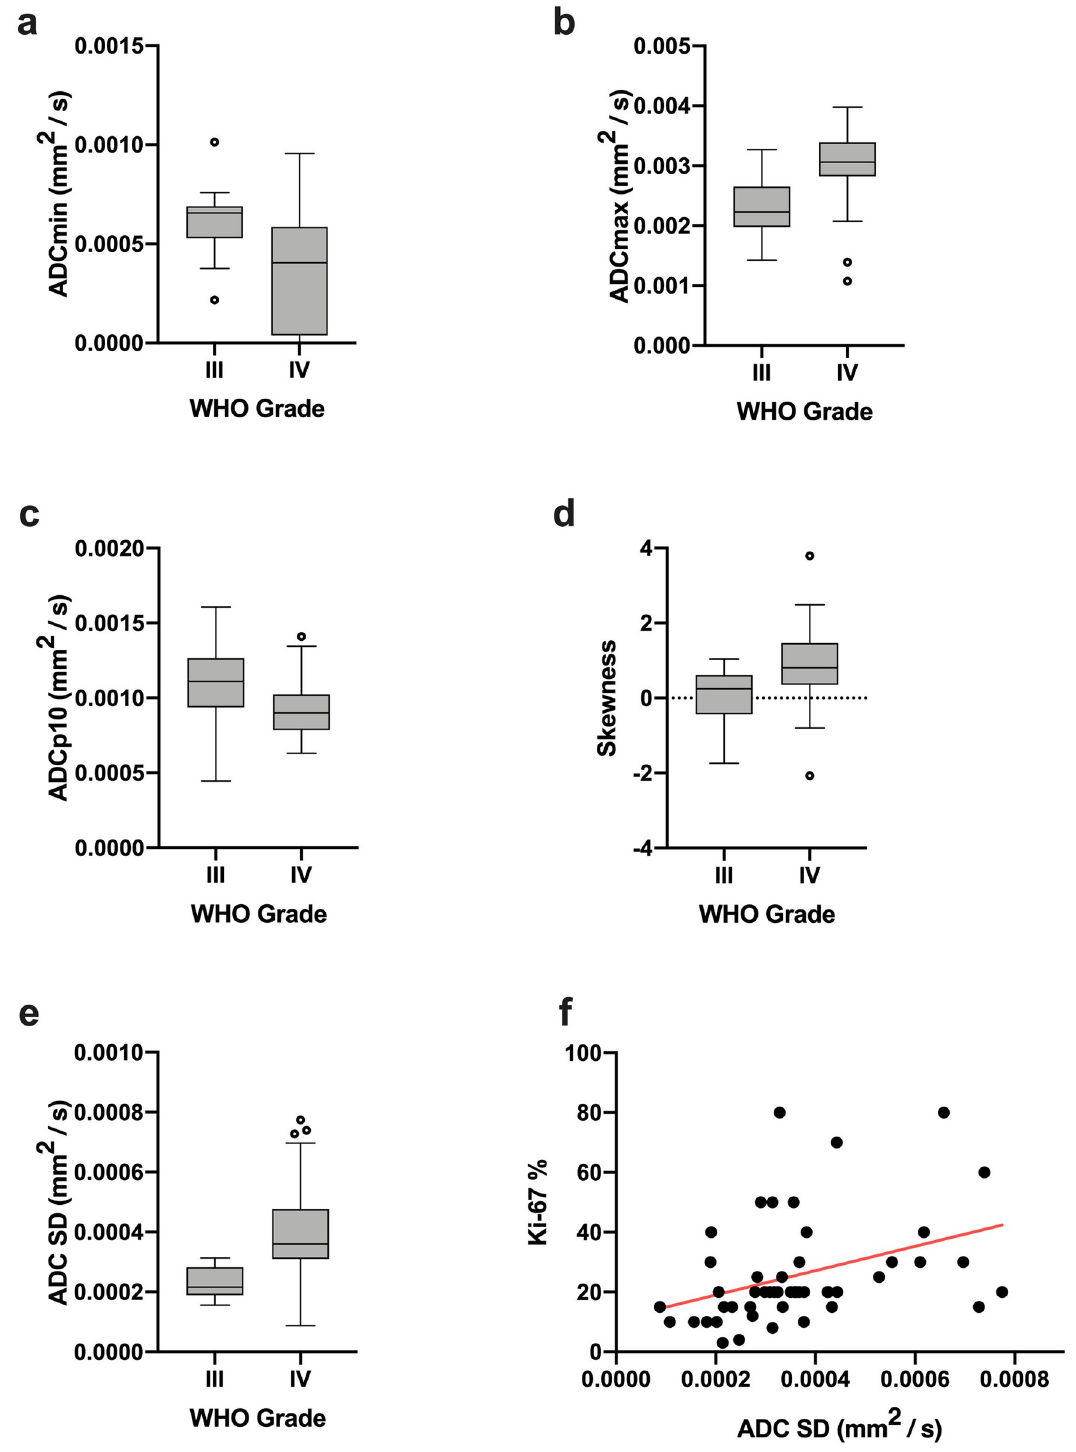
Fig 2. Significant different ADC histogram parameters between grade III and IV gliomas, correlation between ADC SD and Ki- 67. Fig 2 displays boxplots of ADC histogram parameters that differed significantly between grade III and grade IV gliomas (a-e). The strongest correlation (between ADC SD of the whole tumor ADC histograms and the proliferation index Ki-67; r = 0.4608, p = 0.0008) is illustrated in image (f).